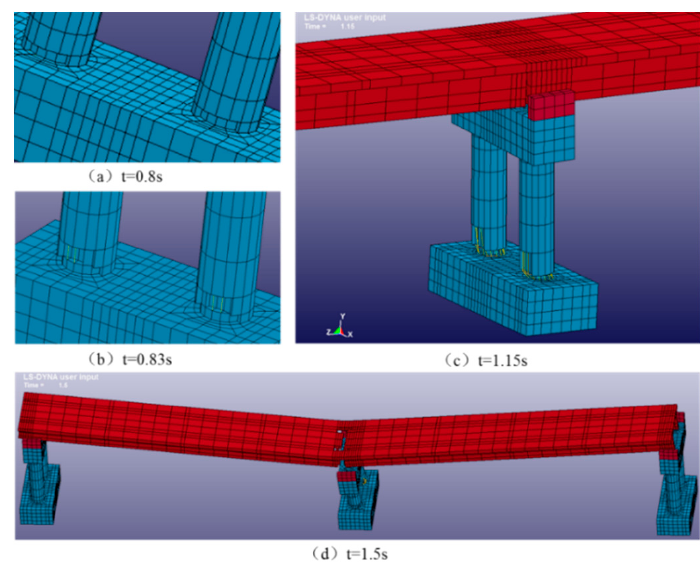
Figure 12. Longitudinal collapse mode of the CHDR system under the El Centro wave.